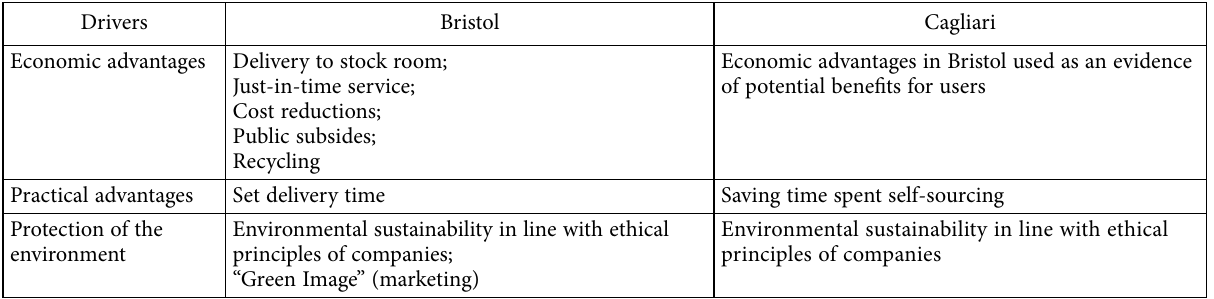
Table 2. Summary of the main drivers highlighted in the cases of Bristol and Cagliari